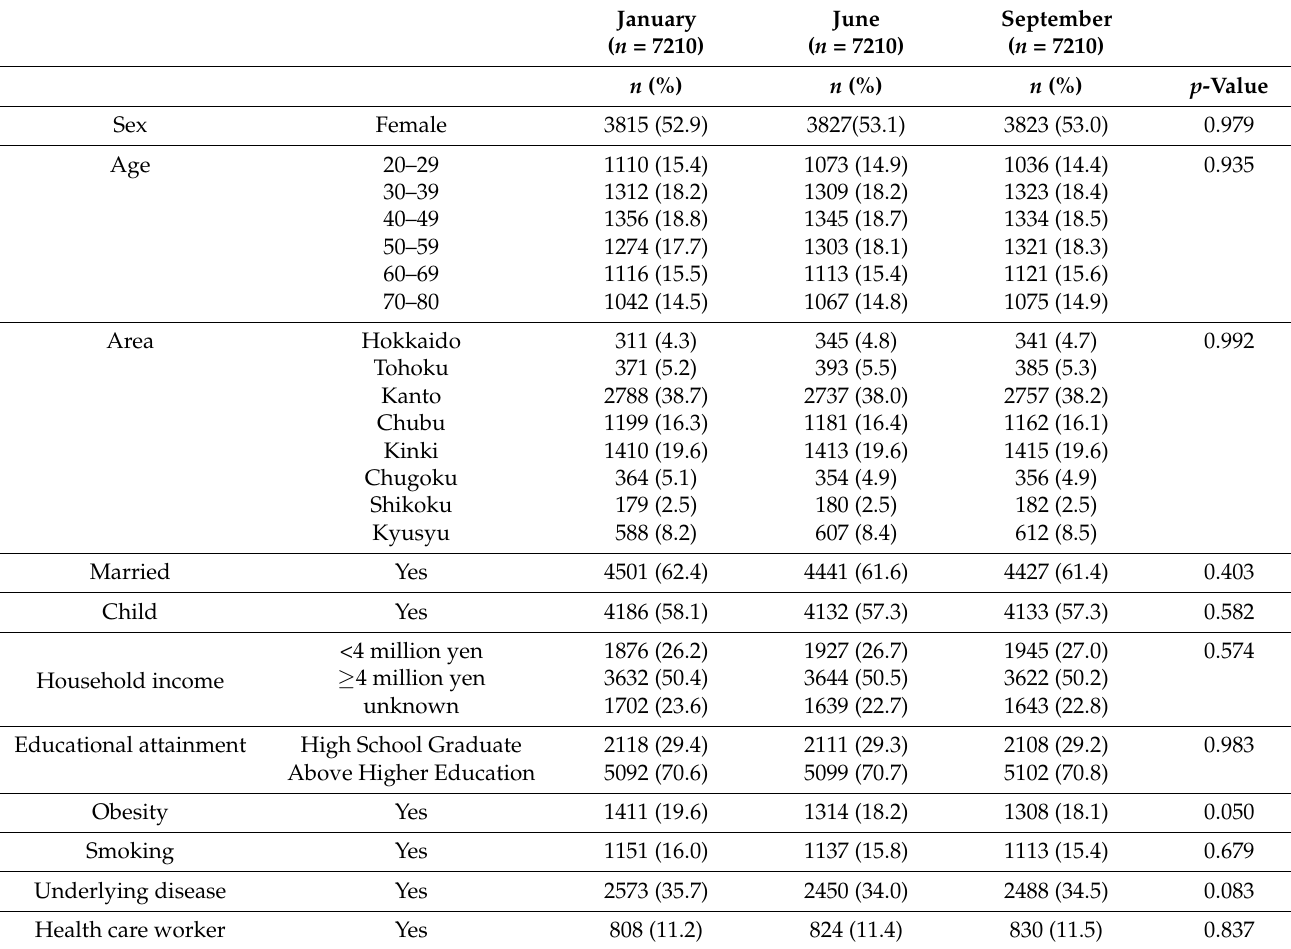
Table 1. Characteristics of